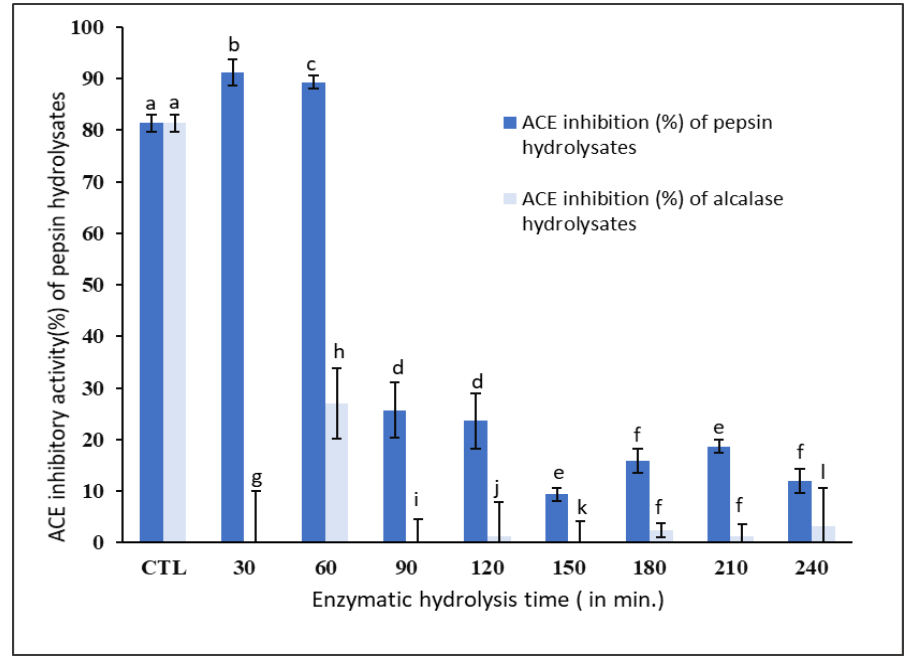
Figure 3. Percentage angiotensin-converting enzyme (ACE) inhibitory activity of pepsin and alcalase hydrolysates. Values with different superscripts (a, b, c, ….) indicate significant differences between sample means at p < 0.05. The control (CTL) was captopril.